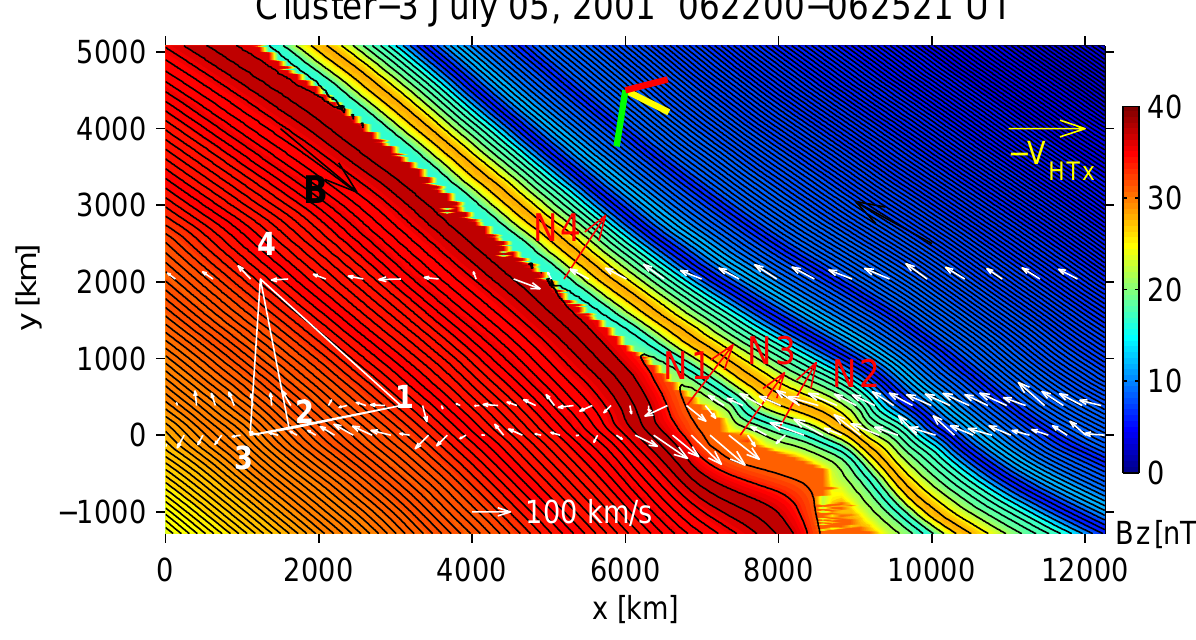
Fig. 12. Magnetic field map reconstructed for the C3 magnetopause crossing on 5 July 2001. The format is the same as in Fig. 9, except that the normal vectors are shown as red arrows.